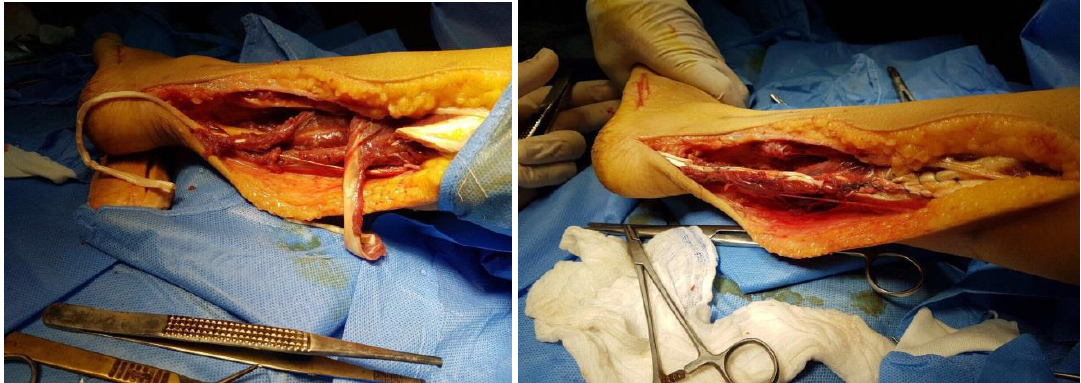
Fig 3: Tendons transfer before suturing Fig 4: Tendons transfer after